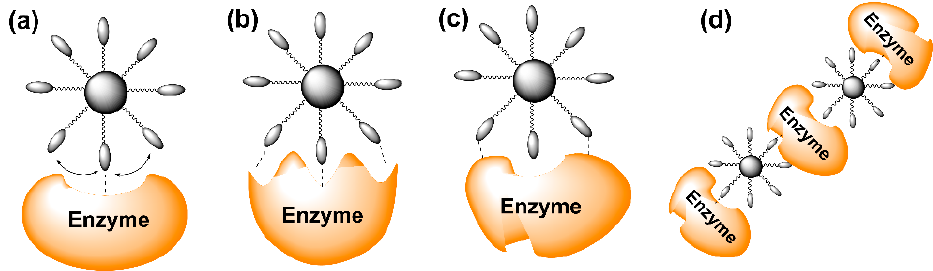
Figure 2 . Proposed binding models accounting for the multivalent effect: ( a ) Bind and recapture; ( b ) Chelate process; ( c ) Subsite binding; ( d ) Cross-linking and aggregation.